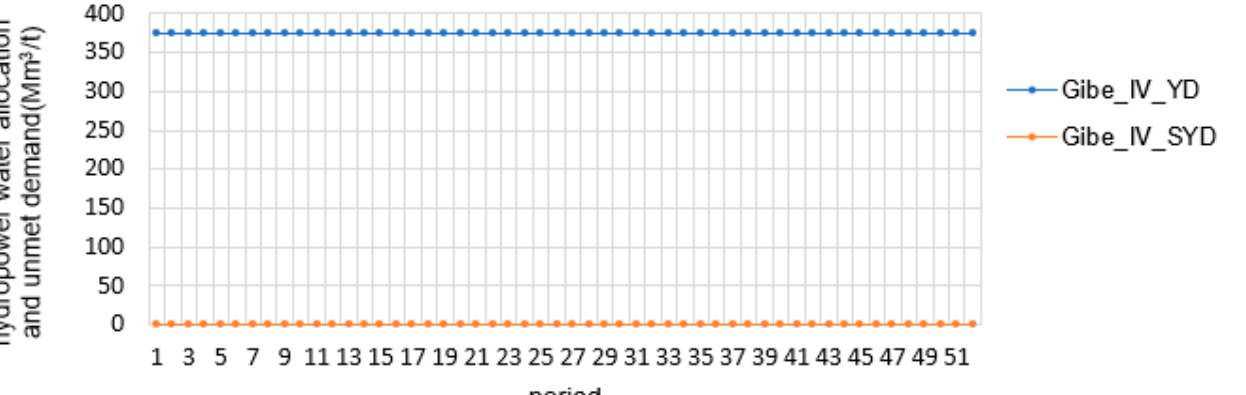
Figure 25. Water allocation and unmet demand water flow for the Gibe III hydropower station. (Mm 3 /week).